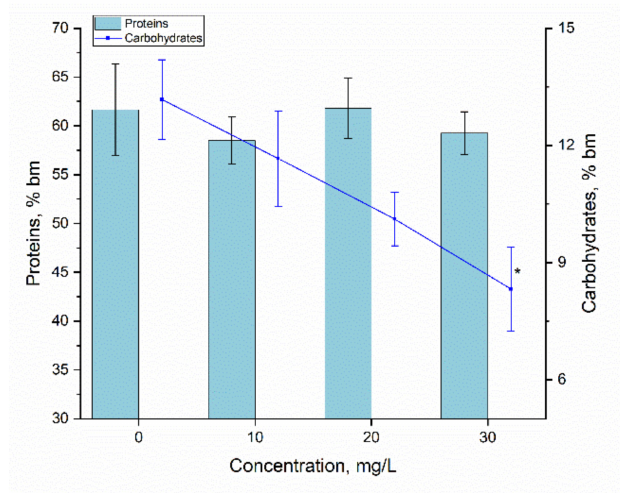
Figure 7. The content of proteins and carbohydrates in Arthrospira platensis exposed to Er(III) at concentrations 10–30 mg/L (* − p = 0.039 for the difference between control and experimental sample—carbohydrates).